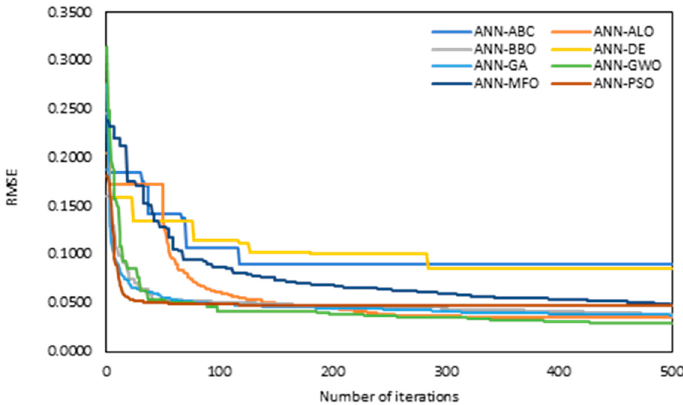
Figure 8. Convergence curves of PCA-based hybrid ANNs.